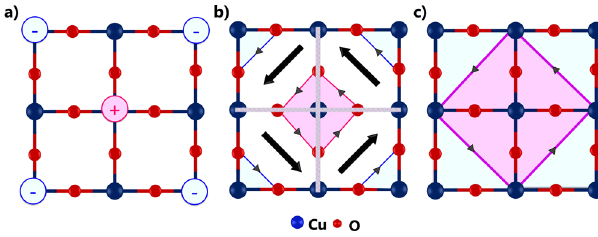
Fig. 4 Possible models for the biaxial (2a x 2a where a is the cell parameter) planar magnetism in YBa 2 Cu 3 O 6.6 . a Magnetic moments at one over two Cu-site. b Loop currents pattern turning clockwise (in blue) and anti-clockwise (in pink), corresponding to the pattern label P = 1 in ref. 27 . Each cell (size a x a) carries an anapole moment (black arrow). The pattern comprises 4 loop currents states where the anapole undergoes a 90 ∘ rotation between adjacent cells. c Loop currents pattern with a loop size, consisting in a 45 ∘ rotation of the d -wave charge density wave (DDW) pattern with currents running between Cu-sites. All models in a – c reproduce the experimentally measured structure factor (Supplementary Note proposed to break the lattice translation symmetry 27 and where the anapole undergoes a 90 ∘ rotation at each adjacent unit cell 5 , or a staggered loop currents phase with currents running along the diagonals of the CuO 2 planes (Fig. 4c). All these patterns nicely agree with the measured structure factor (Supplementary Note 3).